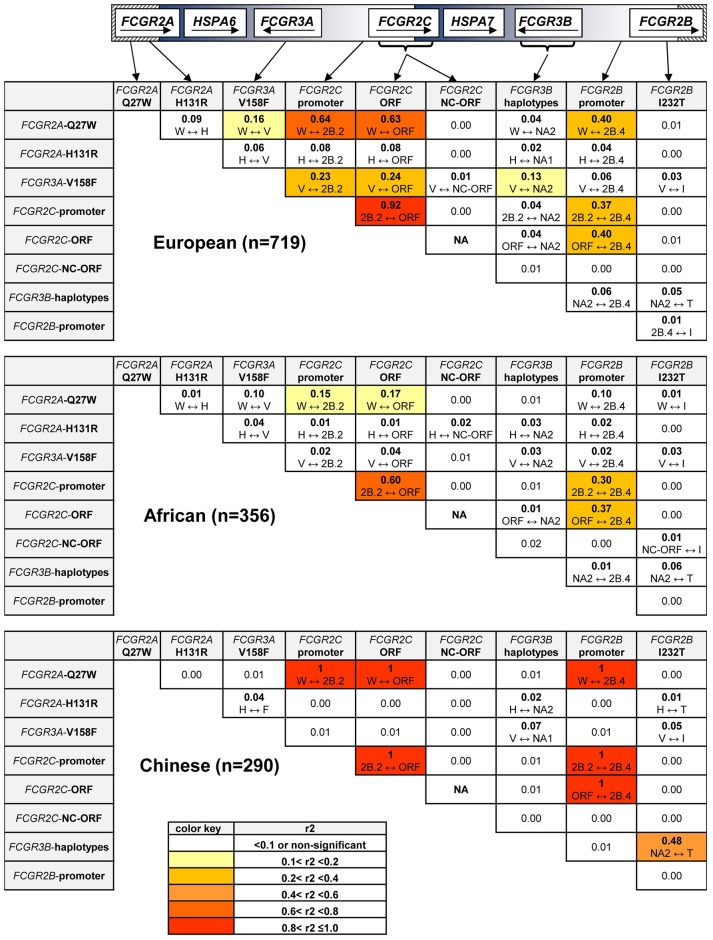
Linkage Disequilibrium at the FCGR2/3 locus. Linkage Disequilibrium for SNPs and haplotypes in individuals without CNV. r2 is shown for all combinations, which variant is linked to which variant is shown underneath. Values shown in bold are significantly different from 0 (p < 0.05). FCGR2C-ORF = classic FCGR2C-ORF haplotype vs. all other FCGR2C haplotypes. FCGR2C-NC-ORF = nonclassic FCGR2C-ORF haplotype vs. all other FCGR2C haplotypes. NA, not available, because the classic FCGR2C-ORF haplotype and nonclassic FCGR2C-ORF haplotype are mutually exclusive. Polymorphic amino acids are indicated by one-letter code.